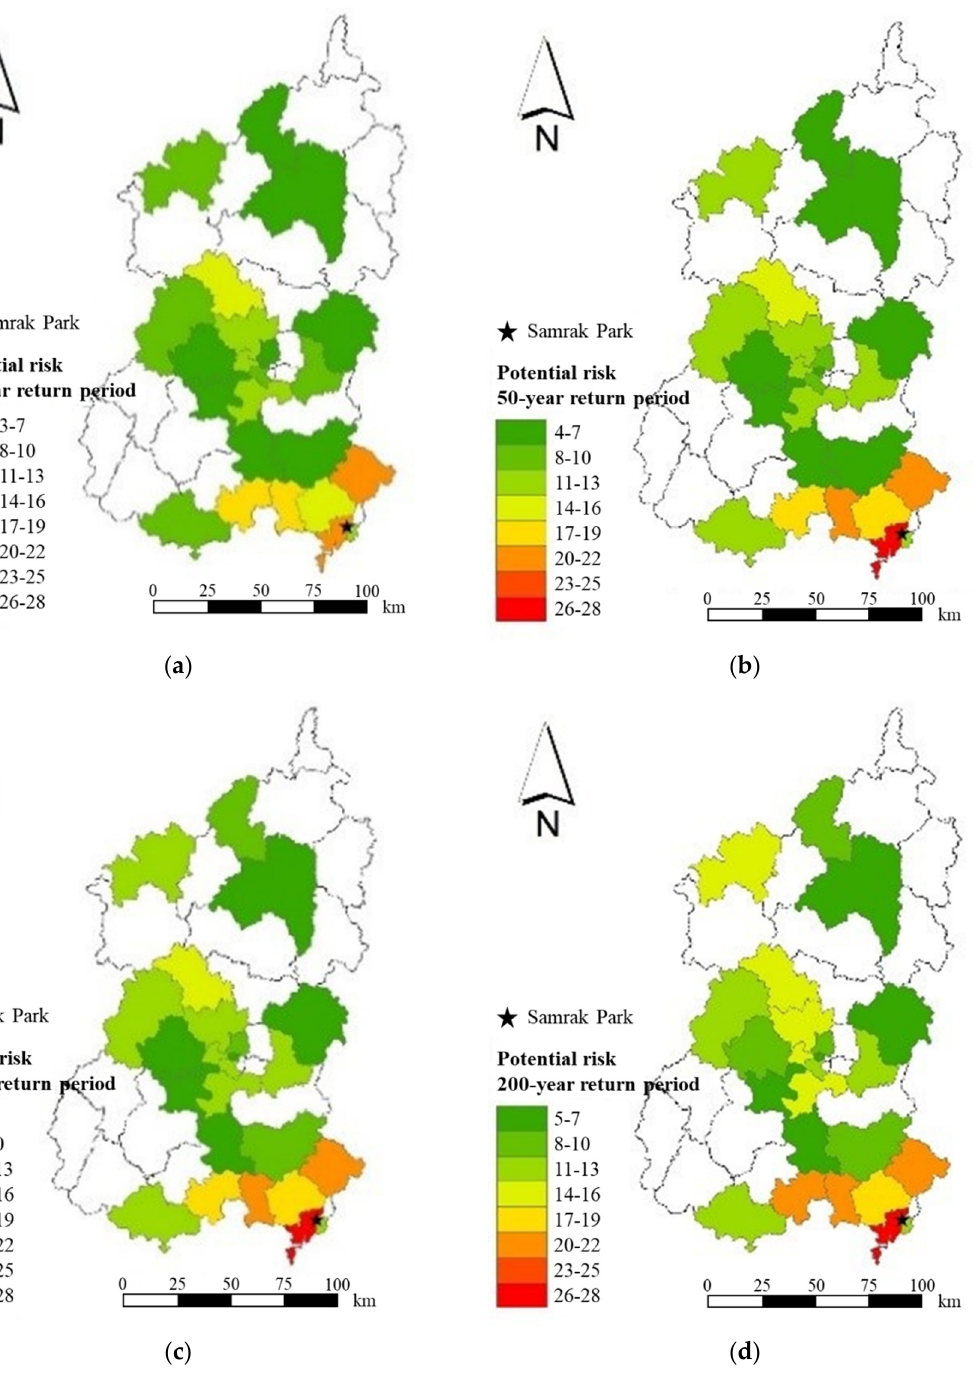
Figure 8. Potential risk distribution in the Nakdong River basin. ( a ) 10-year return period. ( b ) 50-year return period. ( c ) 100-year return period. ( d ) 200-year return period.